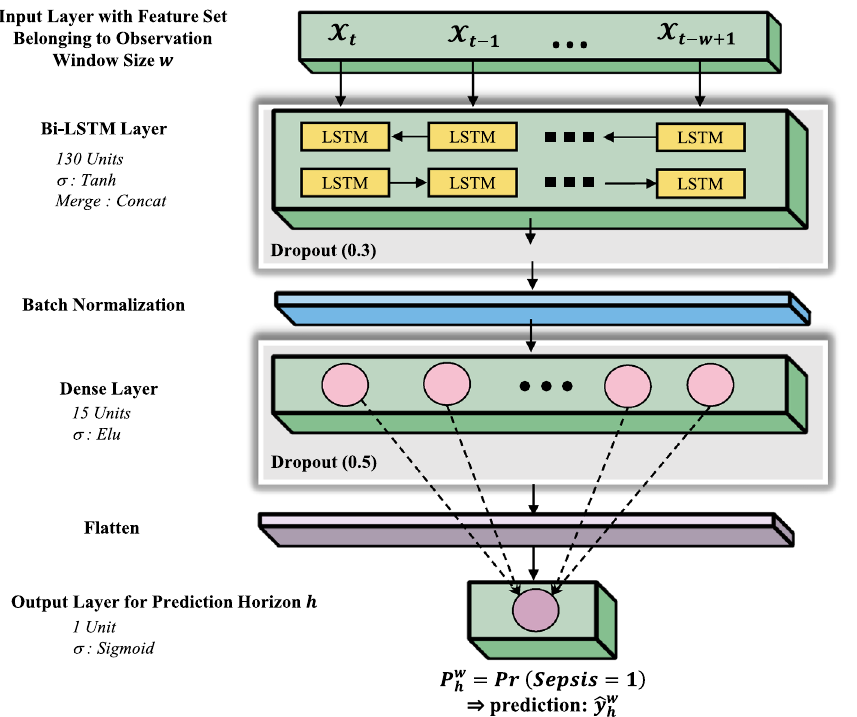
Figure 4. BiLSTM architecture used in this study with prediction horizon h and observation window w